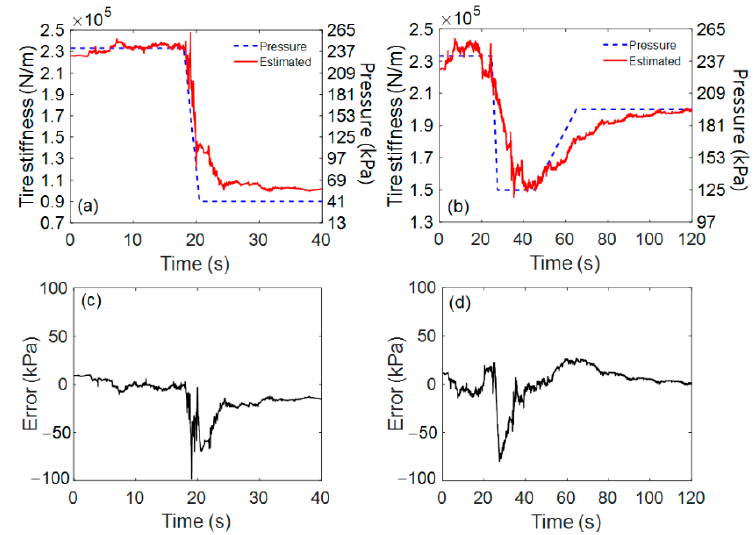
Figure 9. Simulation result of tire stiffness estimation with respect to different pressure drop scenarios; ( a,c ) time response of time-varying tire pressure to slew rate limited input (241.3 kPa → 41.4 kPa) and ( b,d ) time response for arbitrary pressure change (241.3 kPa → 138 kPa → 195 kPa).